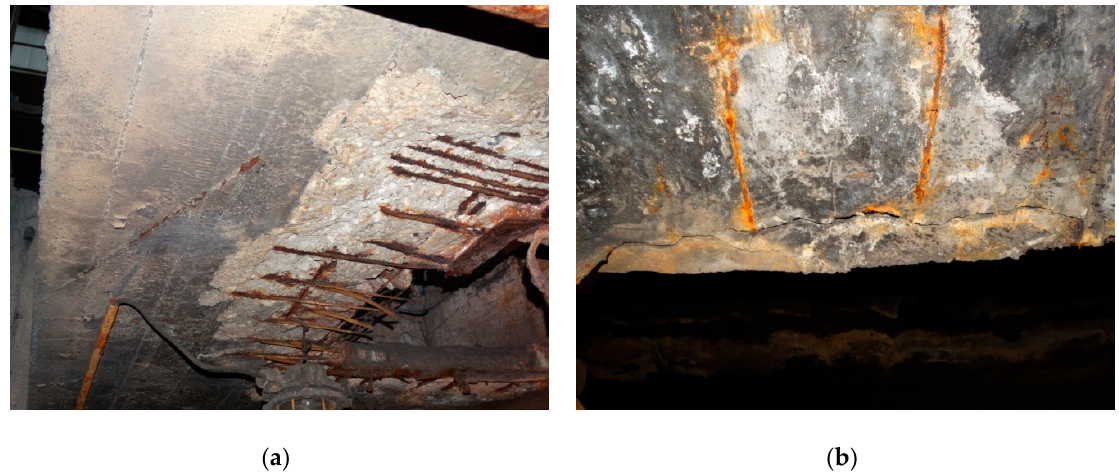
Figure 4. Examples of corrosive damage in A facility: ( a ) concrete and steel corrosion, ( b ) traces of completely corroded stirrups.